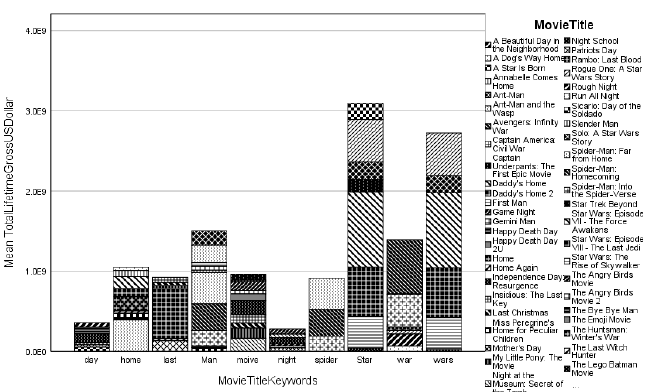
Figure 3. Top 10 most popular movie title keywords and their corresponding movie titles in the United States.